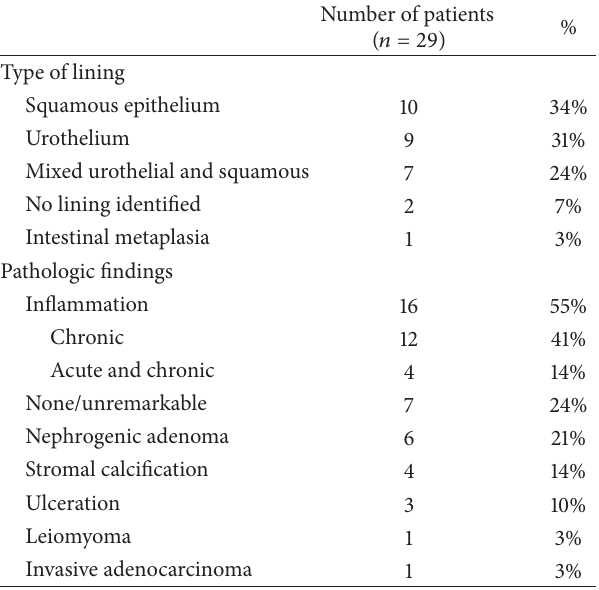
Table 3: Pathologic data for women undergoing surgical resection of urethral